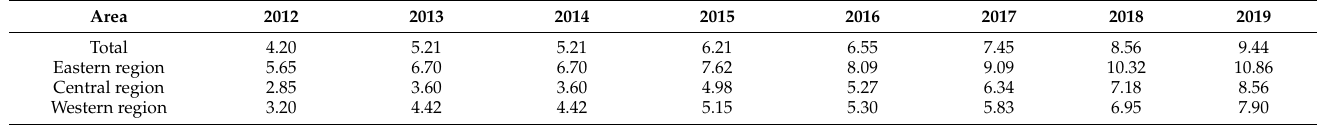
Table 3. The proportion of GPs in practice (assistant) as physicians in China in 2012–2019 (%).